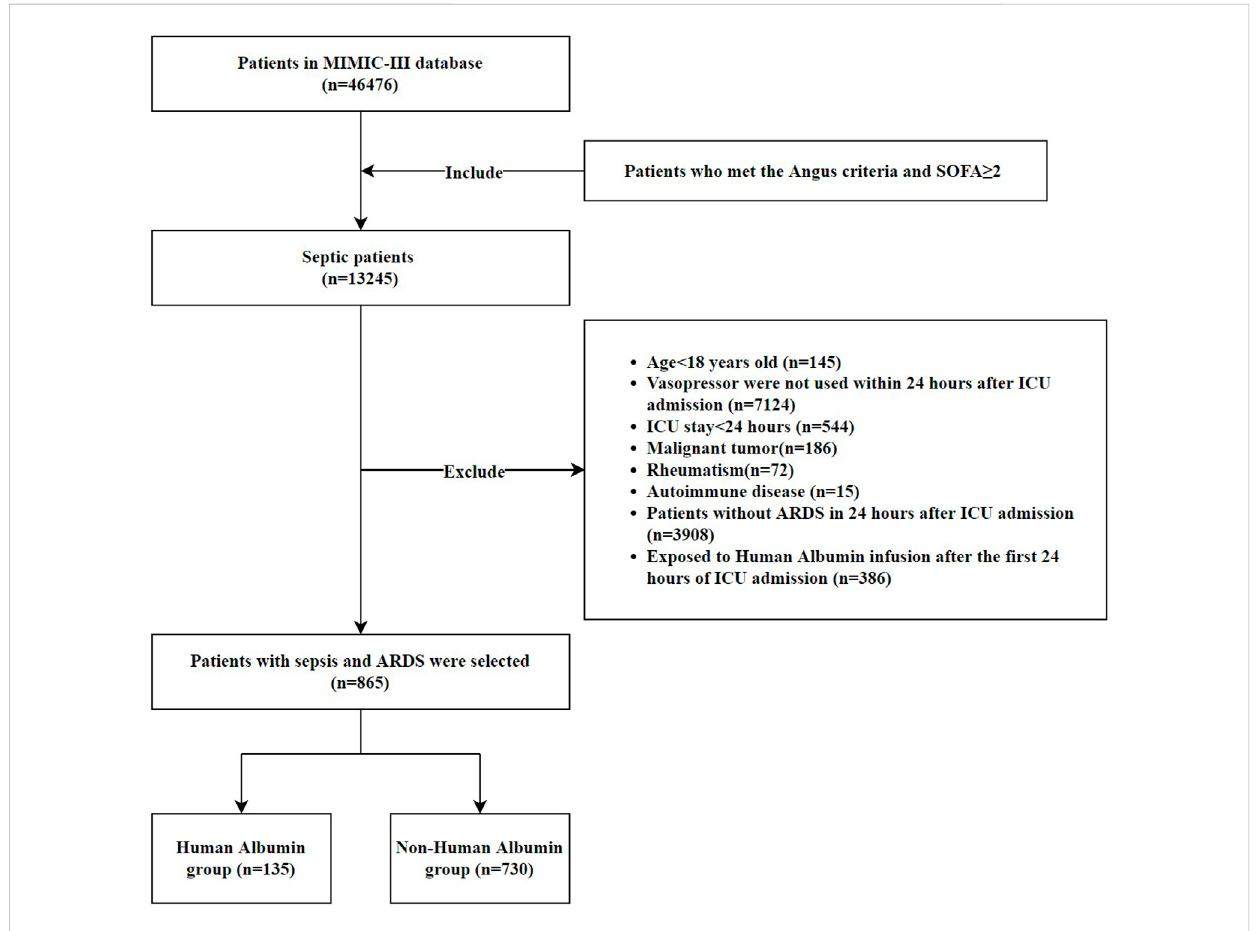
FIGURE 1 Flow chart of the cohort